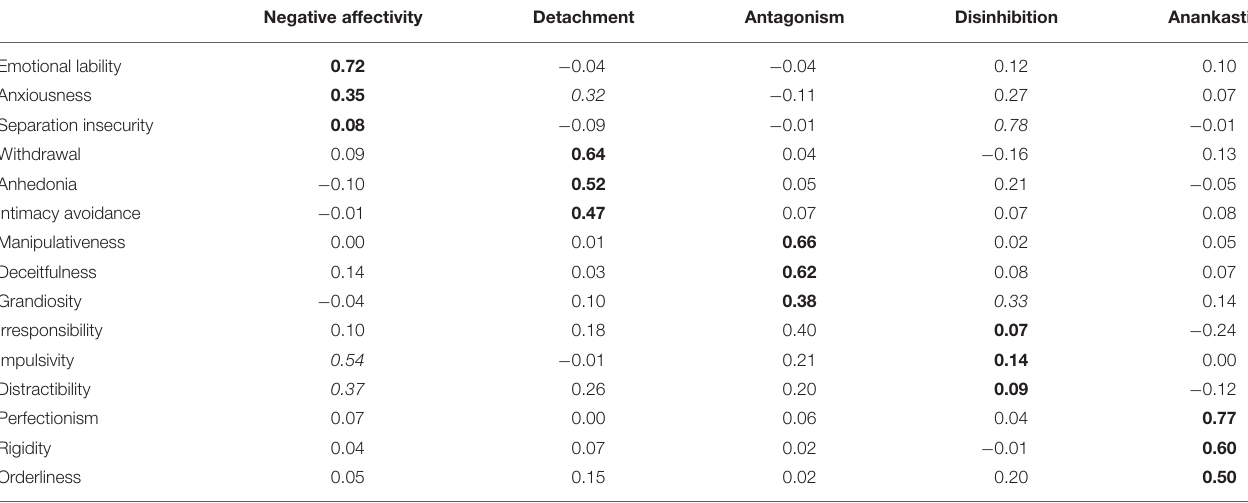
TABLE 3 | Loadings patterns of a 5-factor ICD-11 structure derived from the independent version of PID5BF +